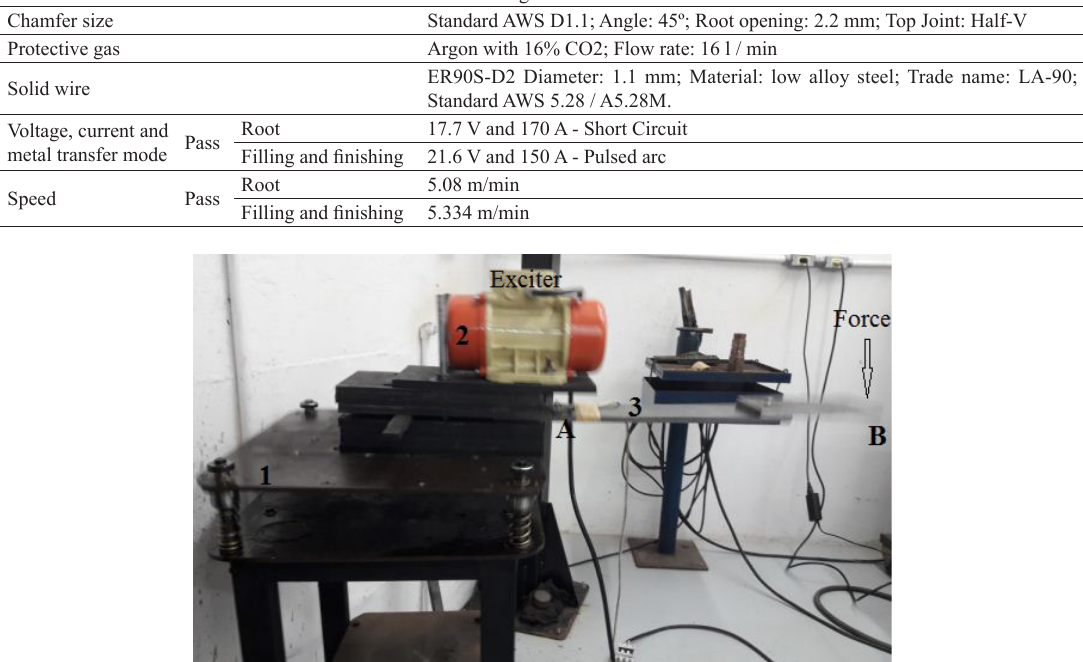
Figure 2. Vibration system: (1) Vibrating table, (2) Eccentric vibrator (Exciter), (3) Sample,